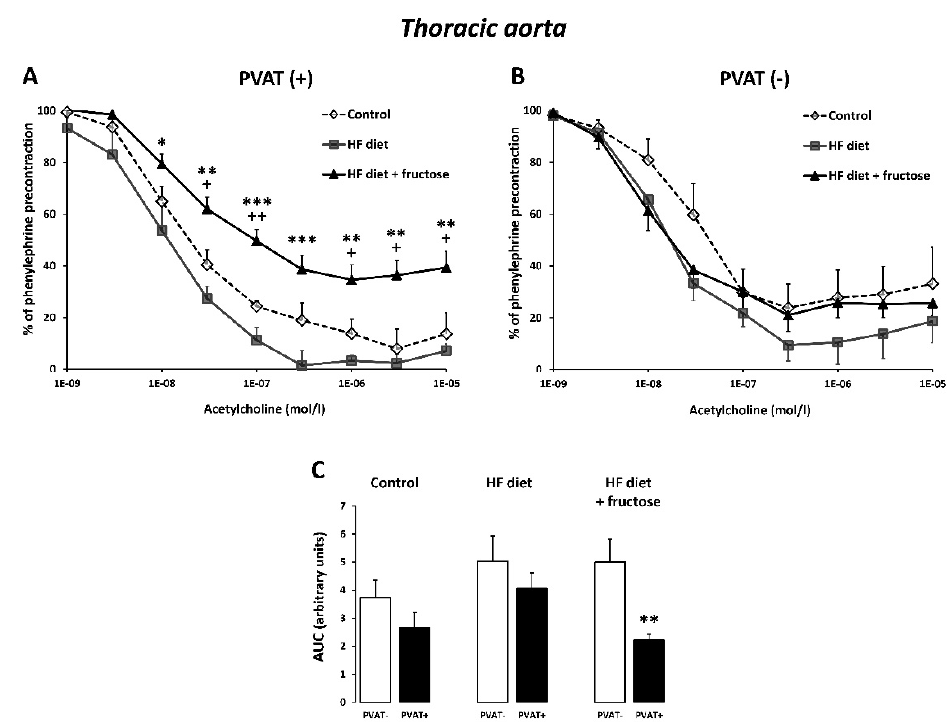
Figure 1. Endothelium-dependent relaxant responses to cumulative doses of acetylcholine in